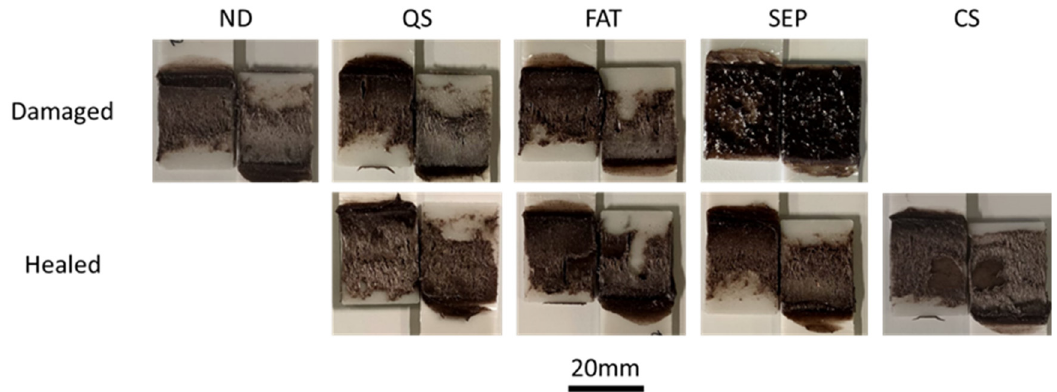
Figure 4. Failure surfaces of the substrates after SLJ tests for the undamaged, damaged, healed, and rebonded specimens.